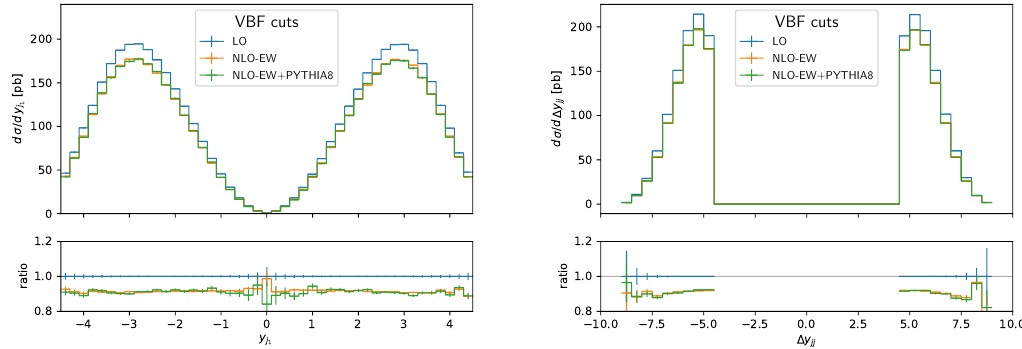
Figure 7 . Rapidity distribution of the hardest tagging jet (left) and rapidity separation of the two tagging jets (right) at LO (blue), NLO-EW (red), and NLO-EW+PS (green) accuracy within the VBF cuts of eqs. (3.5)–(3.8). The ratios of the NLO-EW+PS and the NLO-EW to the LO results are shown in the respective lower panels.